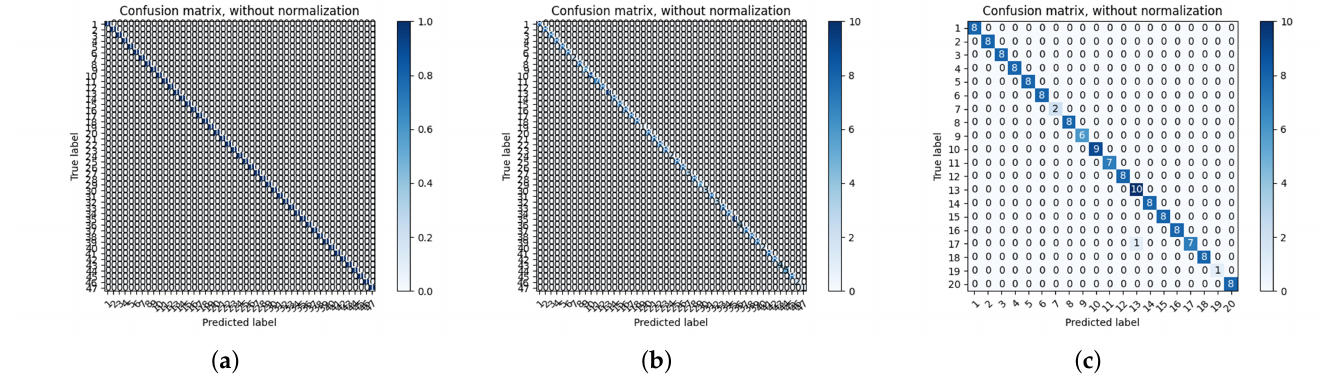
Figure 9. Identification matrix: ( a ) Testing matrix of Group 1 of FRRNet (47 subjects); ( b ) Testing matrix of Group2 of FRRNet (47 subjects); ( c ) Testing matrix of Group 2 of FRRNet (20